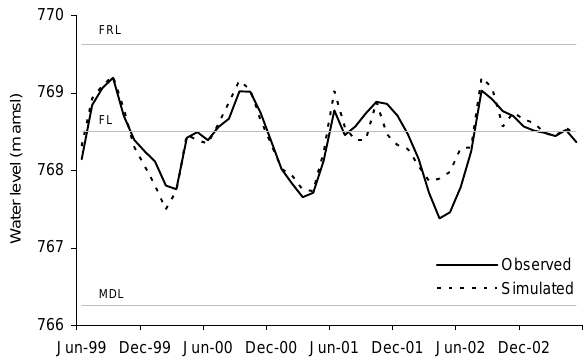
Fig. 8. Observed and simulated mean monthly Loktak Lake water levels (June 1999–May 2003) under baseline conditions (FRL: full reservoir level, FL: flood level, MDL: minimum drawdown